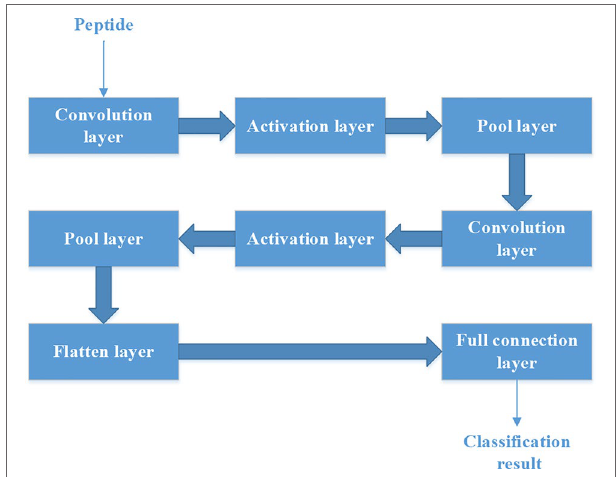
FIgURe 4 | The structure of convolutional neural network.